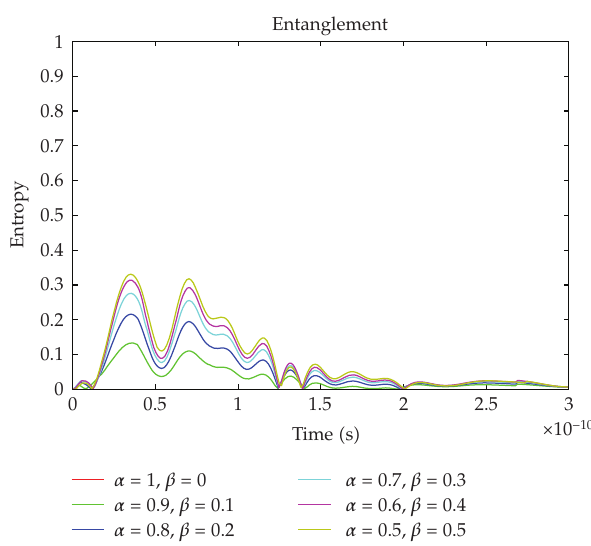
Figure 15: Spin-photon entanglement dynamics for small Δ .